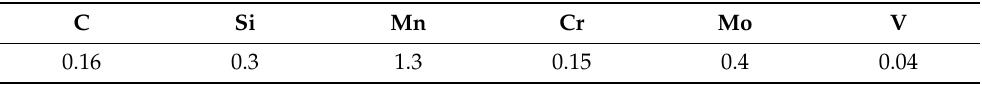
Table 1. The chemical composition of the investigated steel, given in wt% with Fe as the balance. C